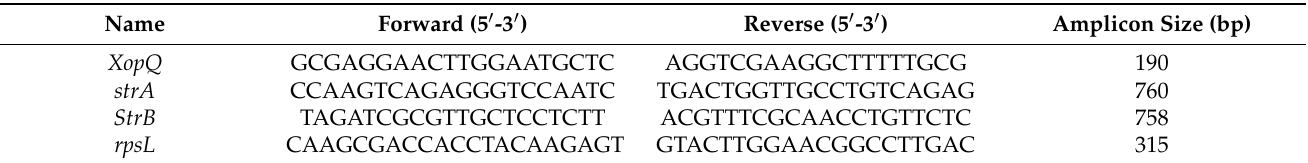
Table 2. List of primers used in the current study.